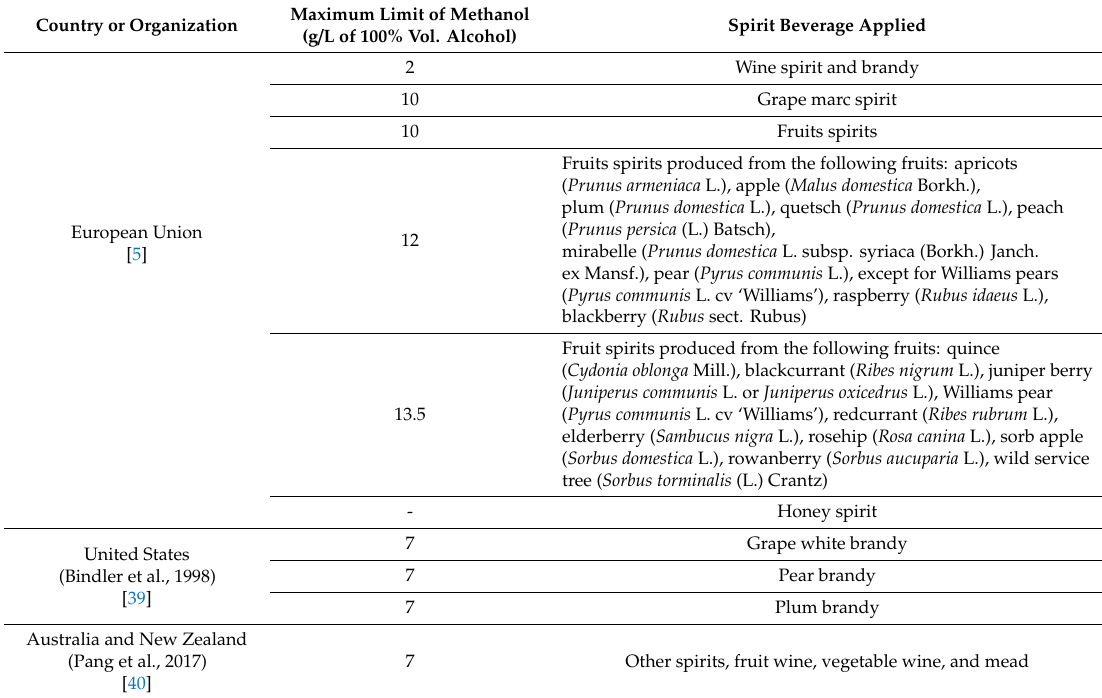
Table 2. Legal limits for methanol contents (in grams per liter of 100% vol. alcohol) in di ff erent spirits. Country or